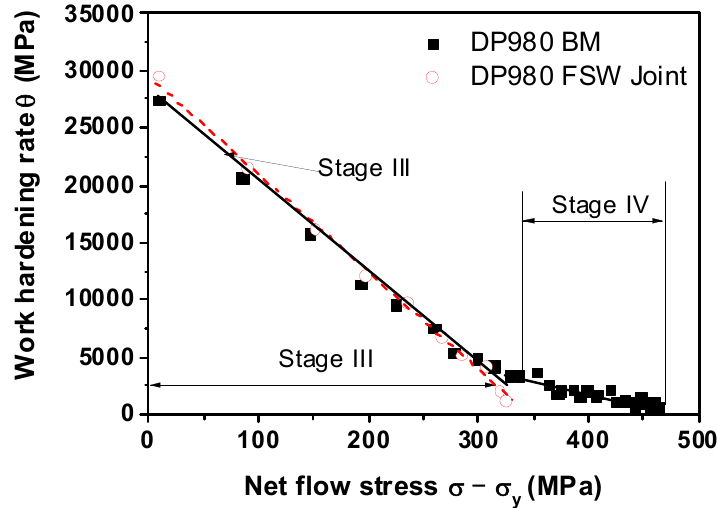
Figure 7. Work hardening rate with respect to net flow stress for DP980 base metal and FSW joint.